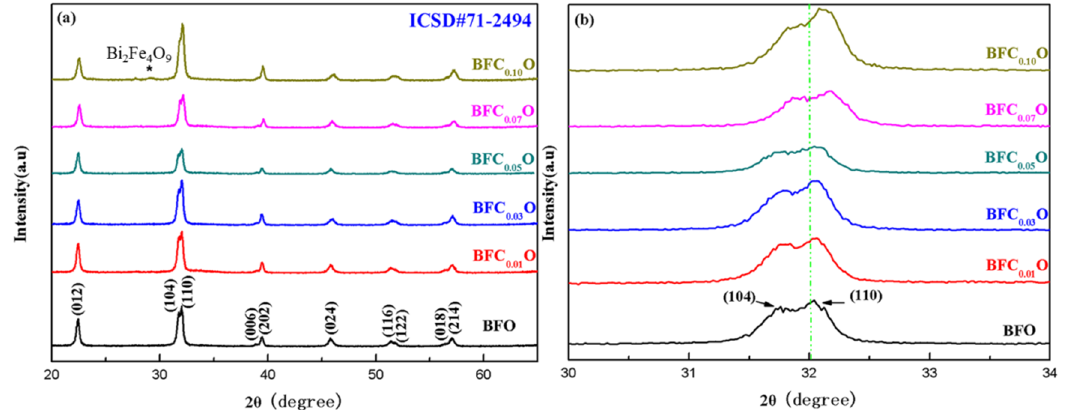
Figure 3. ( a ) XRD patterns of BFO and BFC x O thin films, and ( b ) correspondingly magnified patterns around 32° .